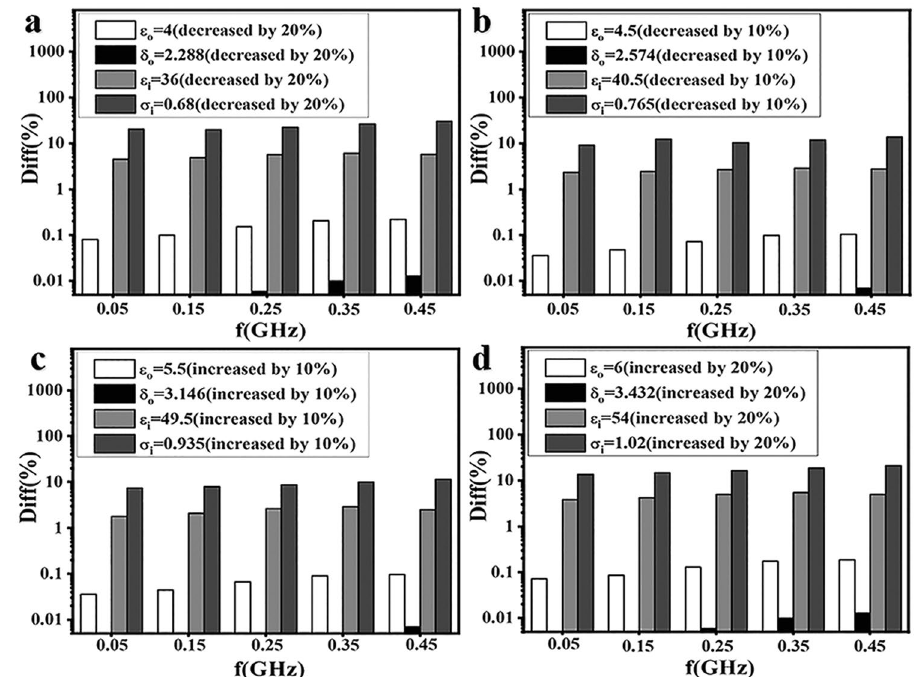
Figure 3. The absolute relative difference between the electric fields in the brain along the Z direction at different frequencies with different adjustment amount of each dielectric parameter. (a) Decreased by 20%, (b) decreased by 10%, (c) increased by 10%, (d) increased by